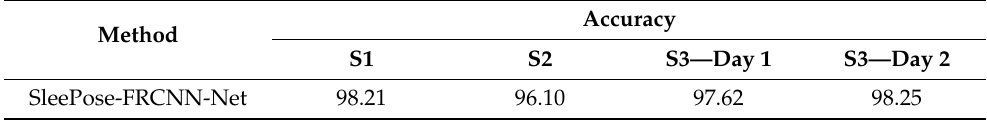
Table 15. Results of upper-body pose classification on the YouTube dataset.